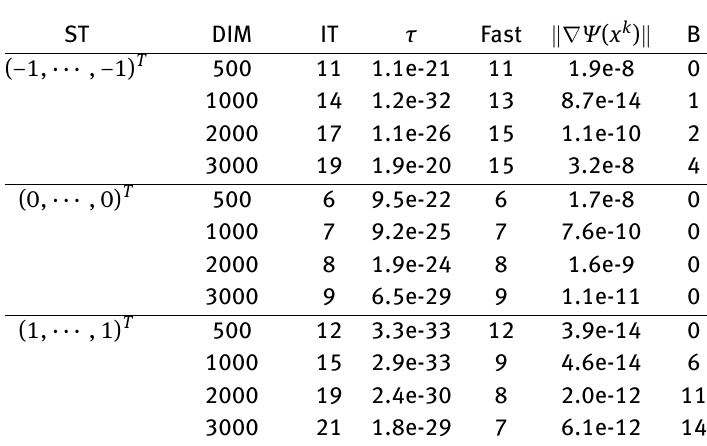
Table 5: Numerical results for Example 5.5 with θ =